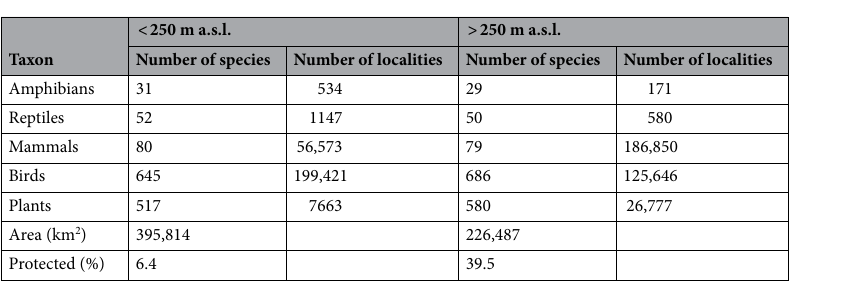
Table 1. Numbers of species and location records used in the analyses for each taxonomic group from localities below and above 250 m above sea-level, and the percentage of the land area in each altitudinal belt